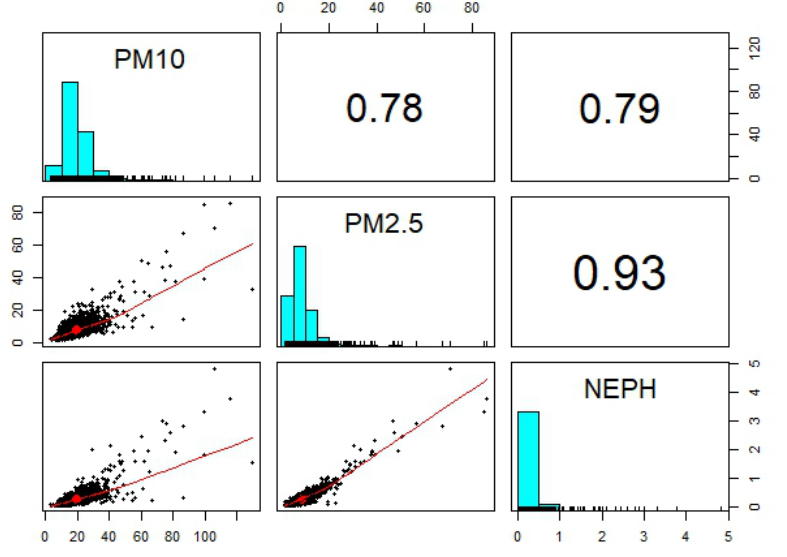
Figure 4. Scatter Plot of Matrices (SPLOM) of PM 10 , PM 2.5 and NEPH. Pearson Correlation Coeffi- cients above the diagonal, histograms on the diagonal, and bivariate scatter plots below the diagonal. Red lines represent the linear regression fits.